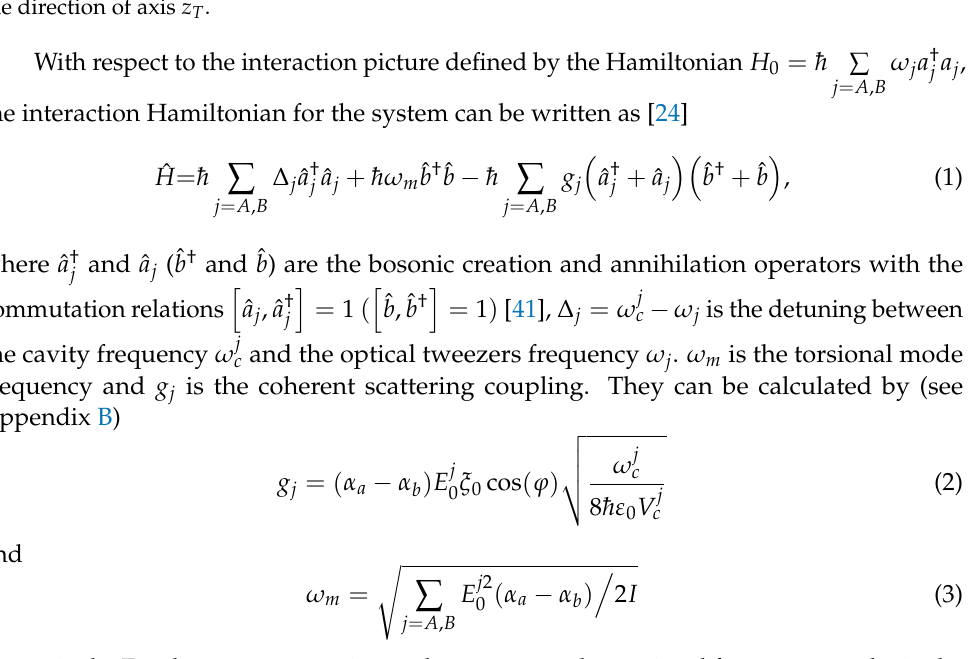
(ˆ a A ) and ˆ a † (ˆ a B ) are excited by B A } with a small angel φ . β is the angel T , y T , z T